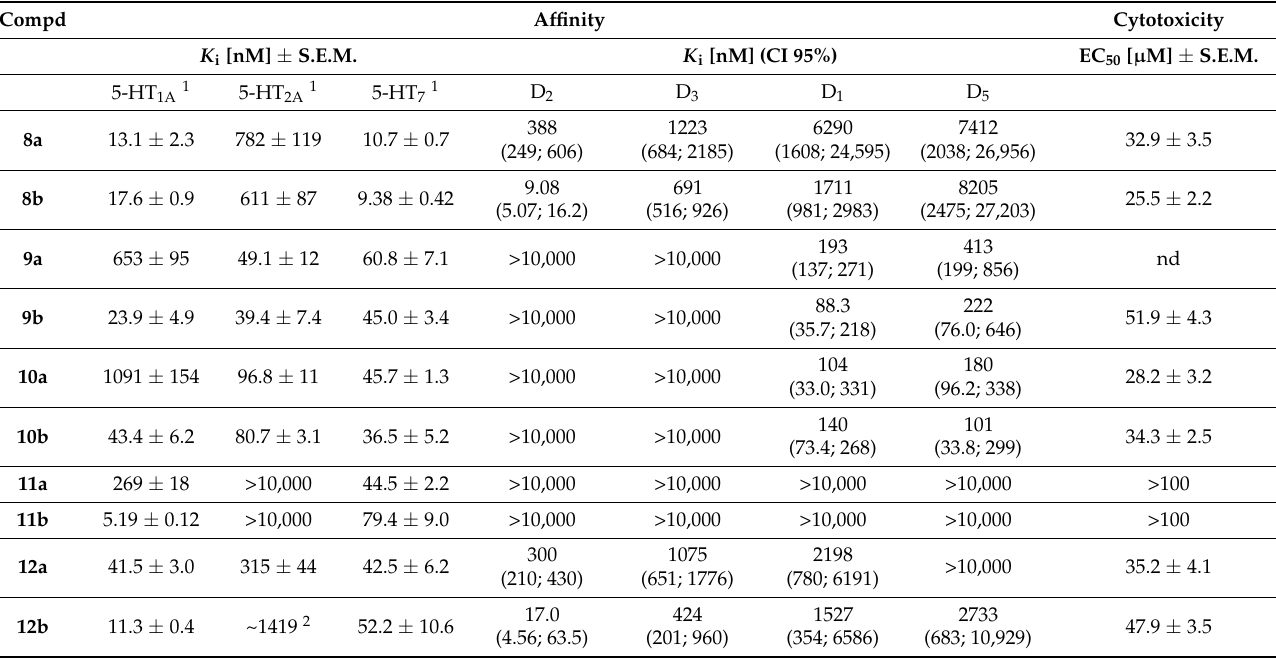
Table 2. Affinity and Cytotoxicity Data of the Target Compounds.